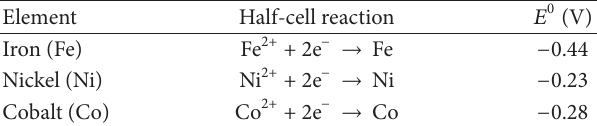
2+ (50mg/L) in the presence of ZVI nanoparticles